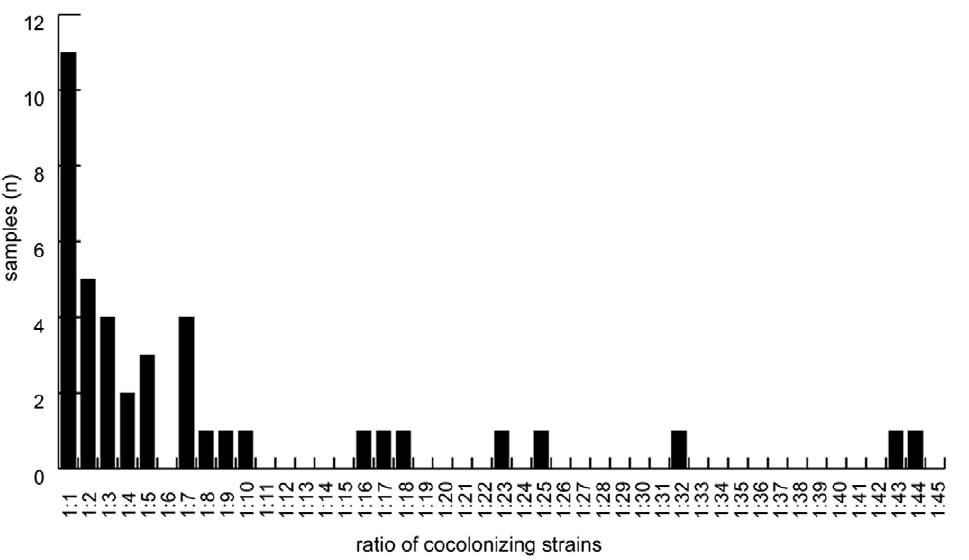
Figure 1. Ratio of strains present in cocolonized nasopharyngeal swabs. Strain ratios were determined from the peak heights in the chromatograms obtained by terminal-restriction fragment length polymorphism analysis (T-RFLP, as described in the methods section). The X-axis indicates the fold-higher presence of the more abundant strain. The three samples with three strains were excluded. doi:10.1371/journal.pone.0011638.g001 vaccination rates were 3.2% for study period 1, 33.3% for study period 3, and 4 were 1.4%, 47.3%, 76.3%, and 88.4%, respectively. 2, 50% for study period 3, and 77.8% for study period 4. The Therefore, study period 1 was considered the ‘‘prevaccine era’’ and corresponding rates for children , 2 years of age for time periods 1, 2, the later seasons combined were defined as the ‘‘vaccine era’’.